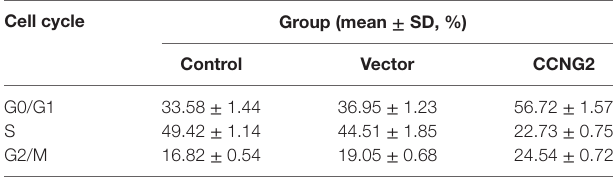
Table 3 | Distribution of the cell cycle in the T98G cell line after transfection. cell cycle